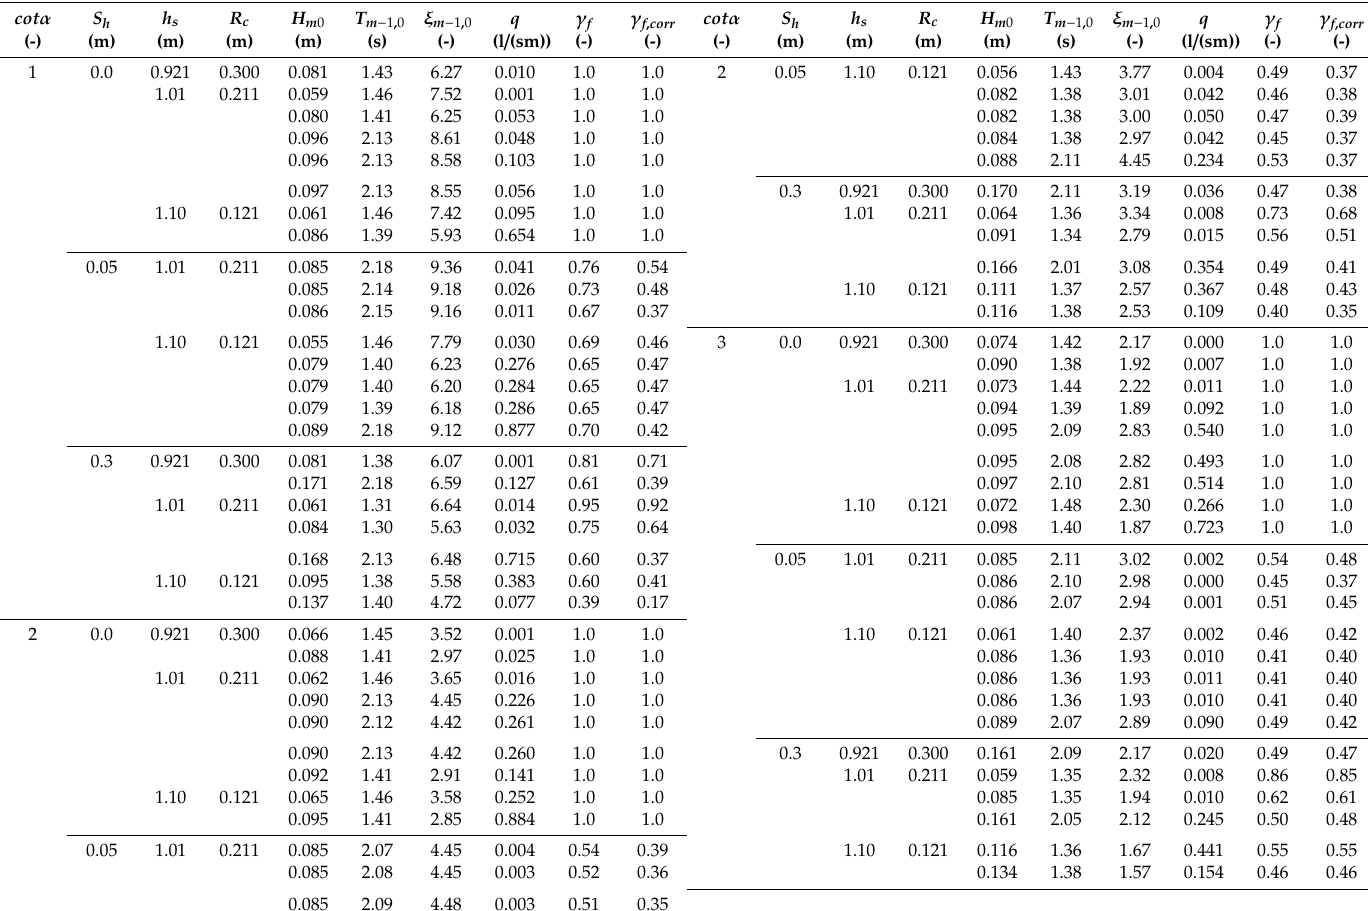
Table 3. Overview of model test parameter, including calculated ( γ f ) and corrected ( γ f , corr ) roughness reduction coe ffi cients for stepped